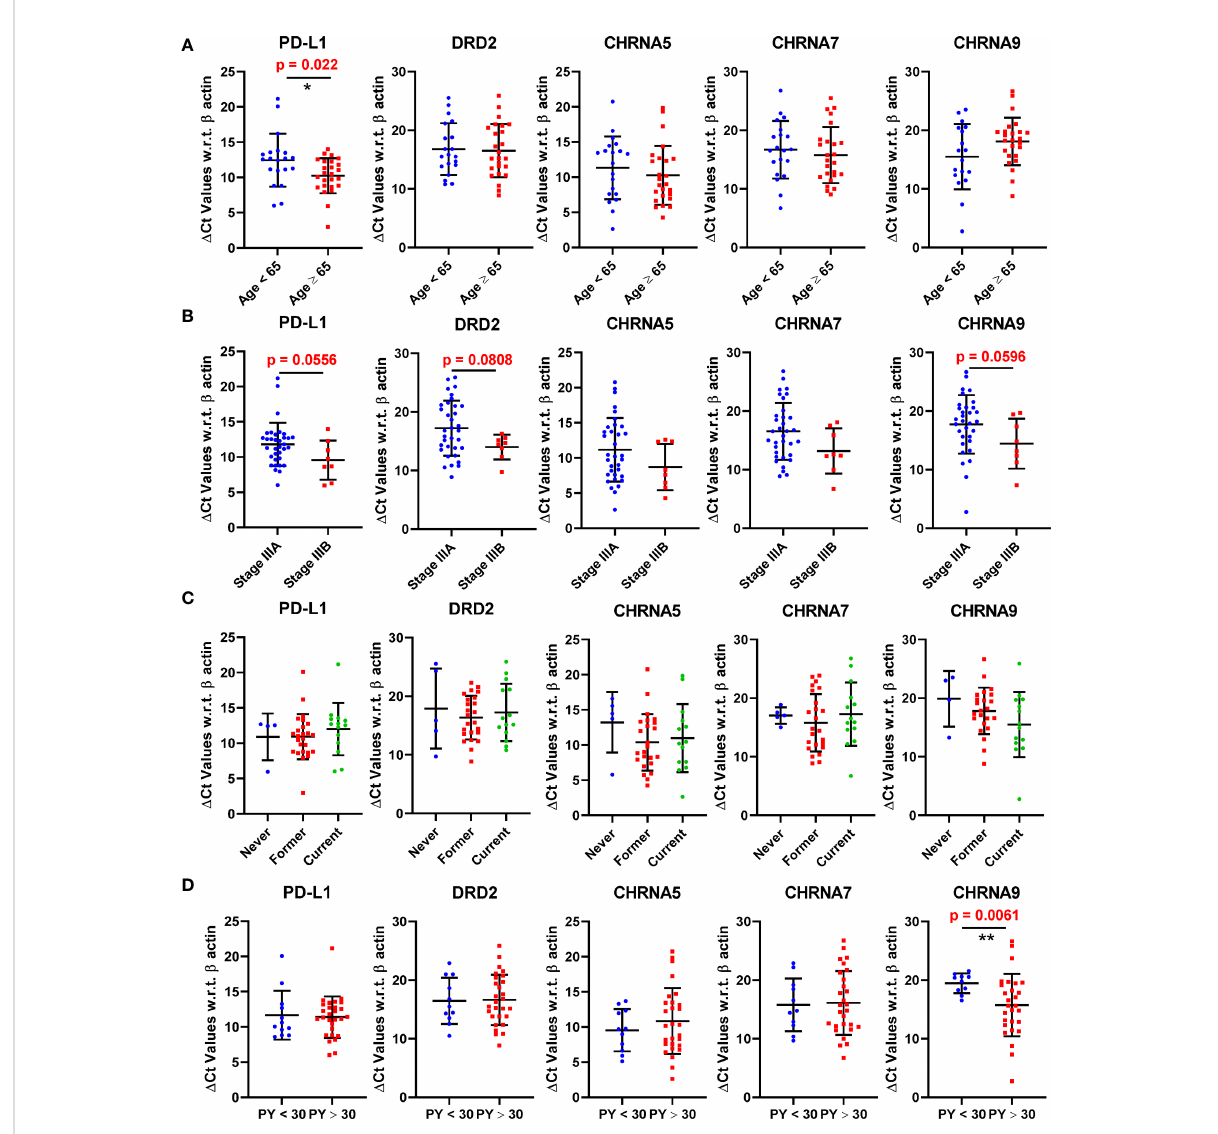
FIGURE 1 Expression of PD-L1, DRD2, CHRNA5, CHRNA7, and CHRNA9 mRNAs represented as D Ct values in patients strati fi ed based on age (A) , Stage (B) , Smoking status (C) , and pack years (D) . A lower D Ct value means the gene expression is higher. * and ** denote p<0.05 and p<0.01